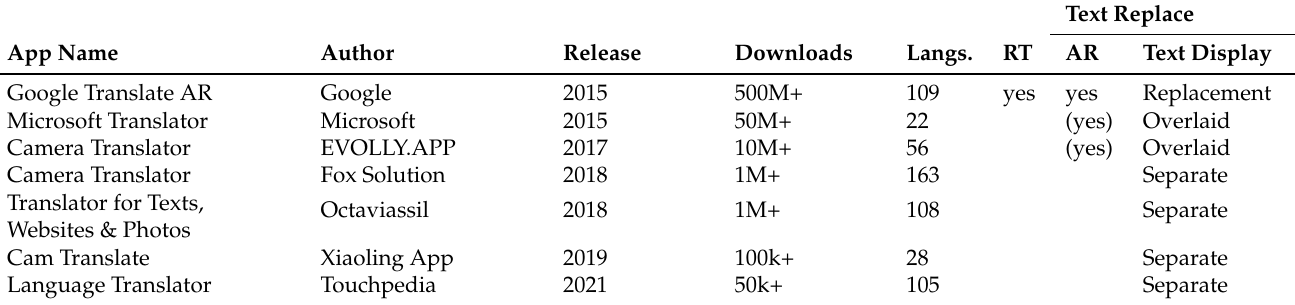
Table 1. All apps found in the Google Play Store (Android) with the query “AR translate” and “Camera translate” on 26 February 2021. Many more translation apps are available that do not feature AR, so only the top ones were analyzed for this comparison. Langs., languages; RT, real